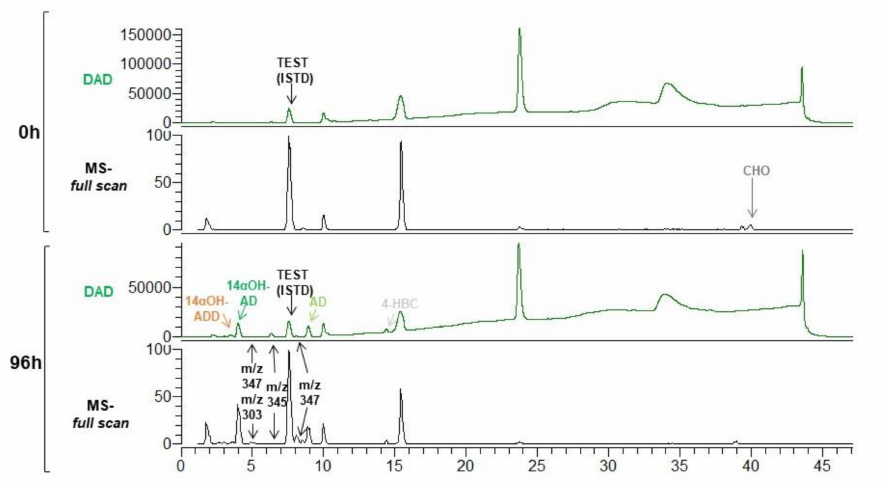
Figure 4. CHO biotransformation by MS6039-5941 (pMVFAN) strain. HPLC-DAD chromatogram (50–600 nm) (green) and and full scan mass spectra ( m / z 150-400) at 0 h and 96 h of growth are